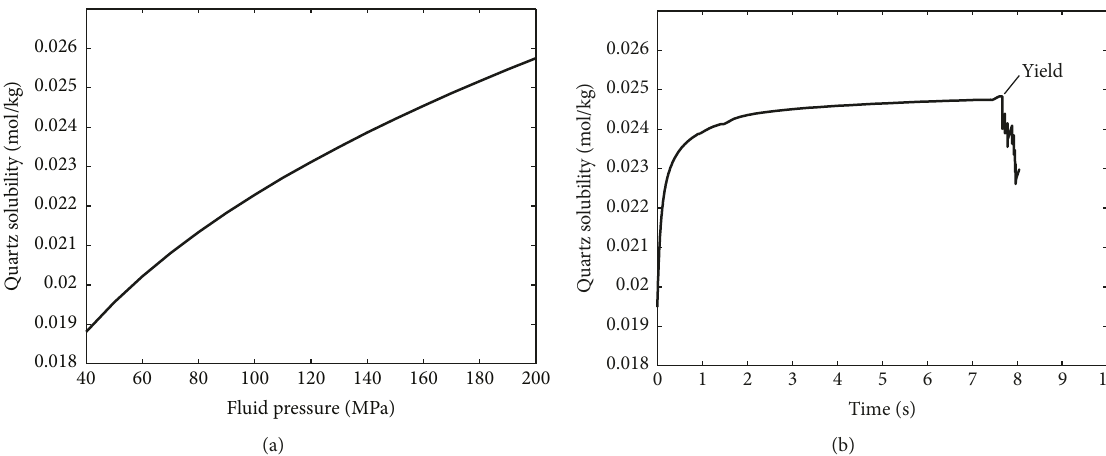
Figure 7: (a) Quartz solubility in aqueous NaCl solutions against fluid pressure at a temperature of 350 ∘ C, reproduced from the solubility model in [87]; (b) the change of quartz solubility at the reference point in the numerical experiments.